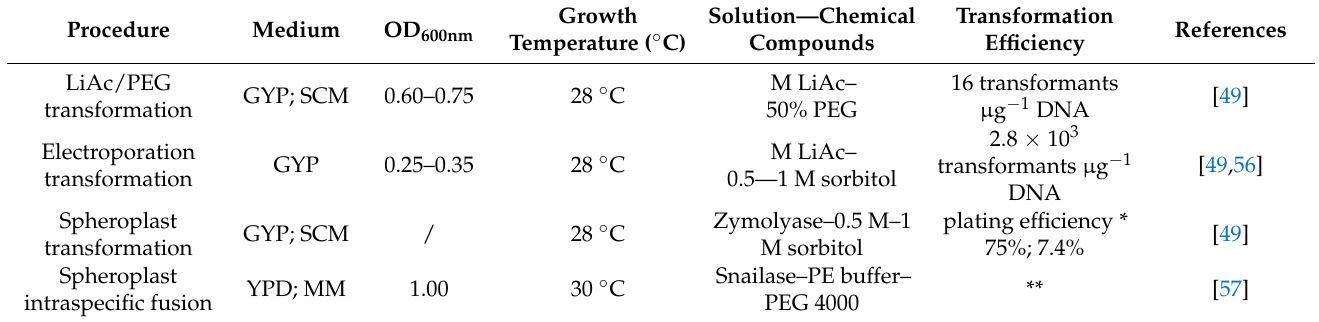
Table 5. Available transformation approaches for B. bruxellensis